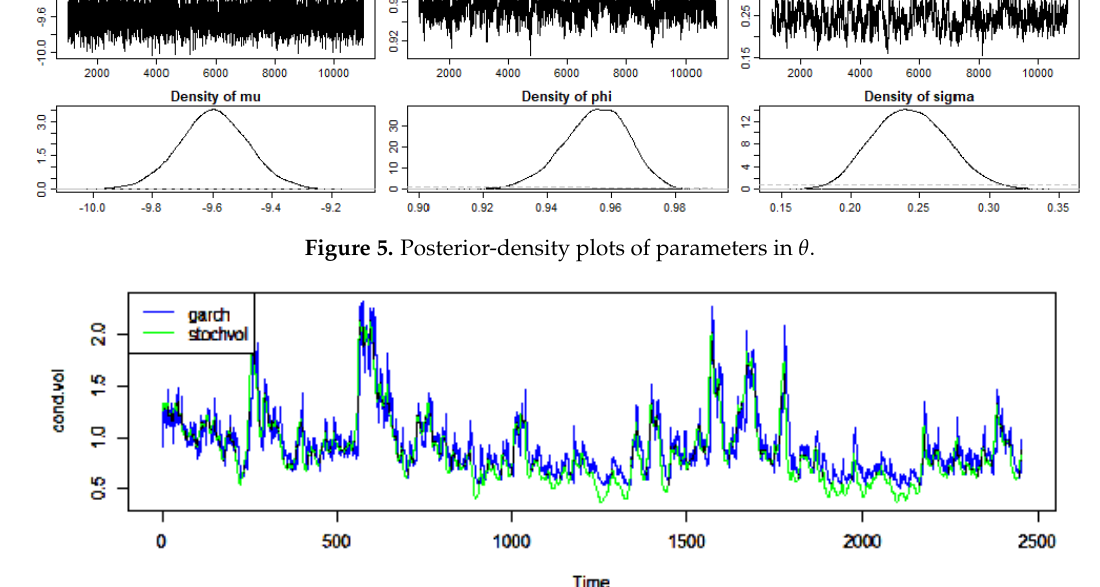
Figure 4. SV estimates.